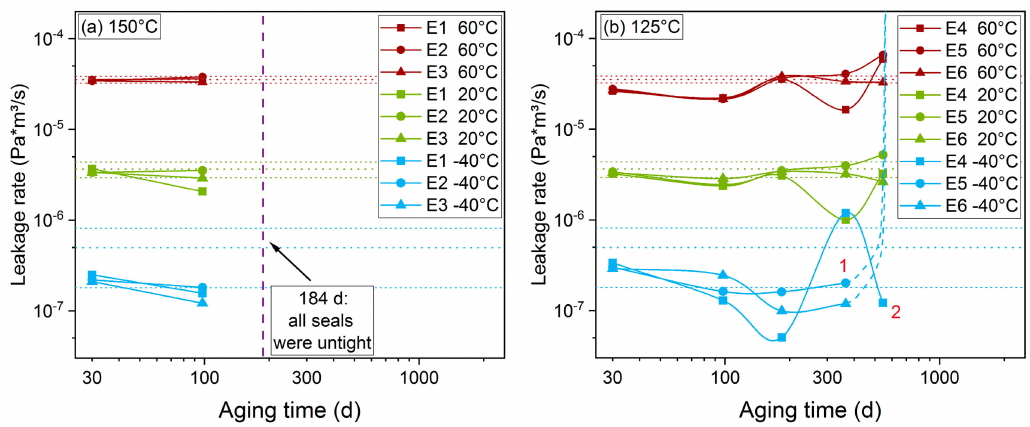
Figure 8. Static leakage rate measured at 60 ◦ C, 20 ◦ C, and − 40 ◦ C on EPDM O-rings aged at ( a ) 150 ◦ C and ( b ) 125 ◦ C. The dotted horizontal lines represent the average value of three unaged O-rings for each test temperature and the respective standard deviation range.